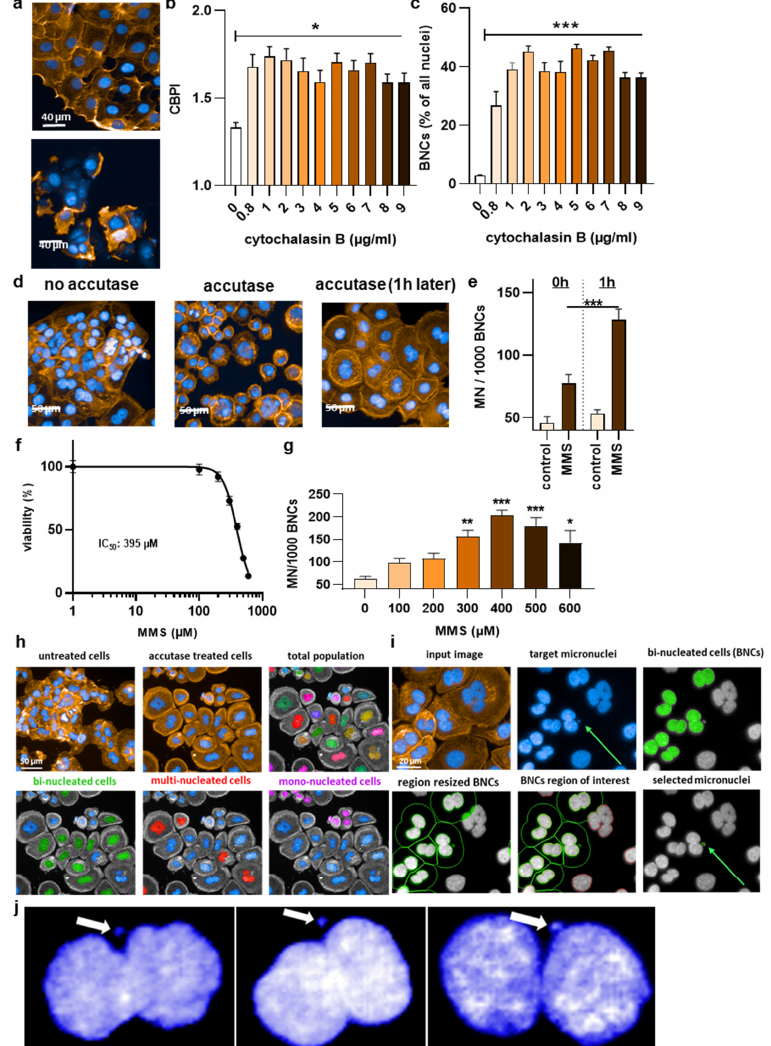
Figure 2. High-content imaging protocol optimization. ( a ) Representative images for the effects of low (upper image) and high (lower image) cytochalasin B concentrations; ( b ) cytokinesis block proliferation index (CBPI) in relation to different cytochalasin concentrations; and ( c ) bi-nucleation rate in relation to different cytochalasin concentrations; ( d ) representative images of the effect of accutase on nuclear segmentation and single cells; ( e ) micronucleation rate at 0 h and 1 h post accutase treatment; ( f ) MMS dose–response curve; ( g ) MMS concentrations in relation to micronucleation rate among bi-nucleated cells (BNCs); ( h ) representative images showing the benefit of accutase treatment to identify nuclei, and algorithm-based sub-grouping from the total population into bi-nucleated cells (BNCs), multinucleated cells, and mono-nucleated cells; ( i ) representative images from the algorithm-driven object segmentation workflow starting with the input image and the identification of bi-nucleated cells from the DAPI-stained nuclear over the identification of the cytosolic area via the phalloidin-stained actin (orange), the removal of cross-contaminating nuclei in these image regions, and the automatic identification of micronuclei (MN) related to bi-nucleated objects; ( j ) representative magnified fluorescence microscopy images of DAPI staining in bi-nucleated cells with micronuclei. Data are representative or mean +/ ± S.E.M. from at least three independent experiments. Statistical analysis was performed using one-way analysis of variances with Dunnett post hoc testing for multiple comparisons ( b , c , g ) or t -test ( e ) with * = p < 0.05, ** = p < 0.01, and *** = p <